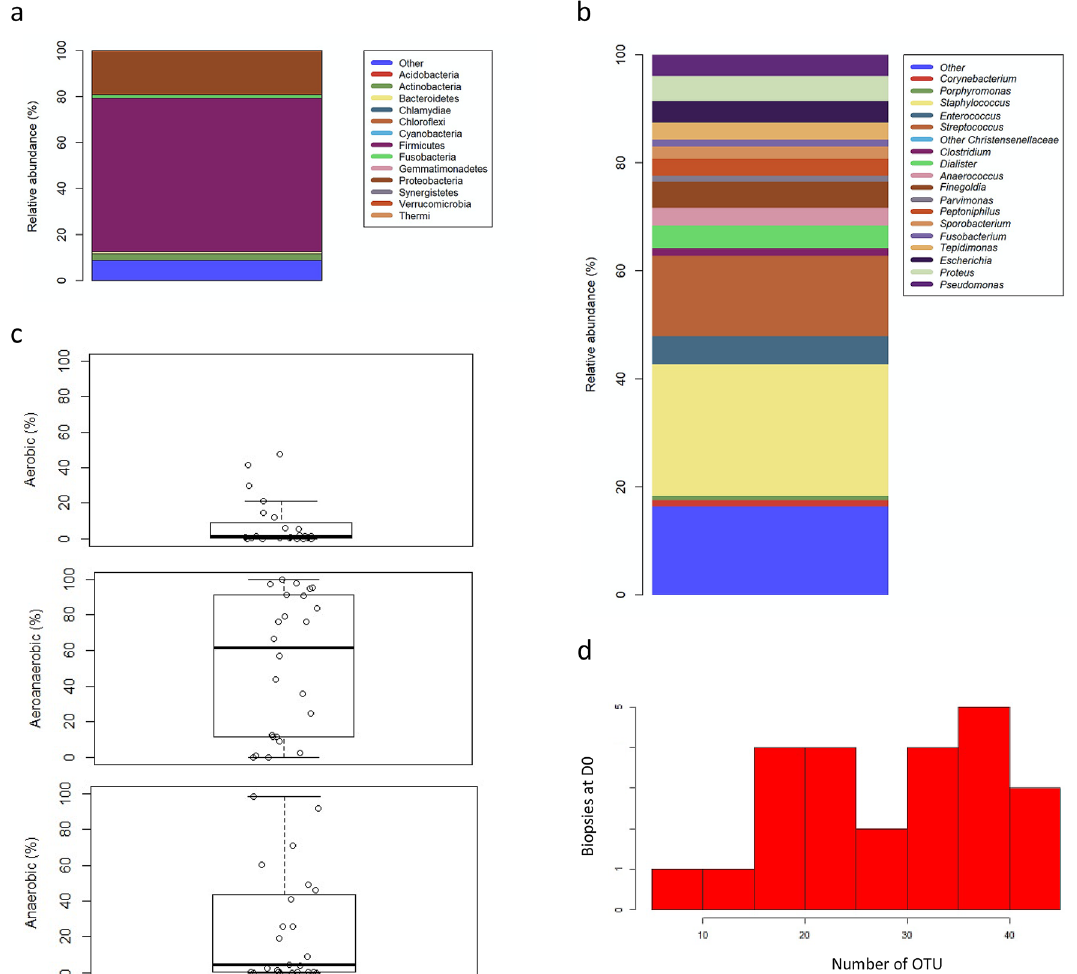
Figure 1. Description of bacterial communities isolated from wounds at D0. ( a ) Barplot of overall repartition of phyla in wounds at D0 for total population (n = 24). ( b ) Barplot of average relative frequencies of genera. Only genera > 1% of OTUs in at least one wound and in at least one time (D0 or/and D28) were represented. The remaining genera are added to the group “other”. ( c ) Boxplot of genus relative frequencies gathered in respiratory phenotype. ( d ) Histogram of OTU’s number by wounds at D0